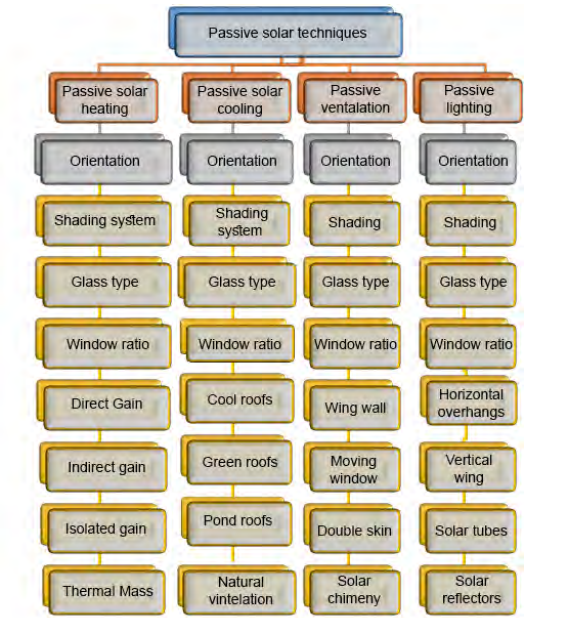
Figure 1. Passive solar strategies to reduce energy consumption inside buildings (Ashmawy, 2015).